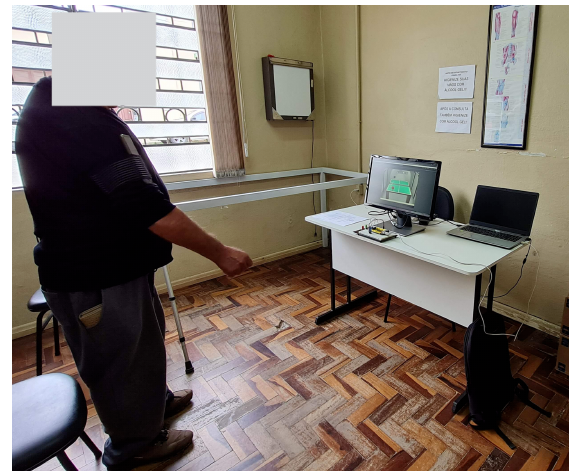
Figure 13. Validation of the solution with the patient 2. Source: Author (2022).